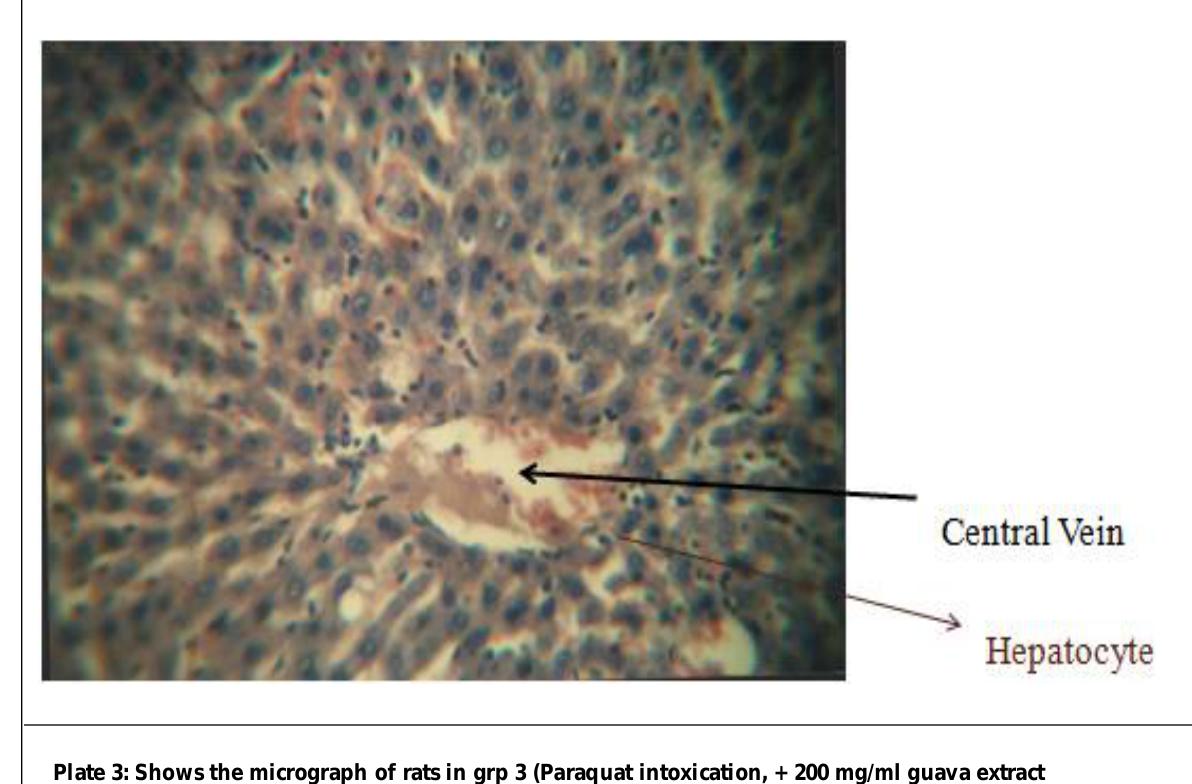
Plate 3: Shows the micrograph of rats in grp 3 (Paraquat intoxication, + 200 mg/ml guava extract treatment)